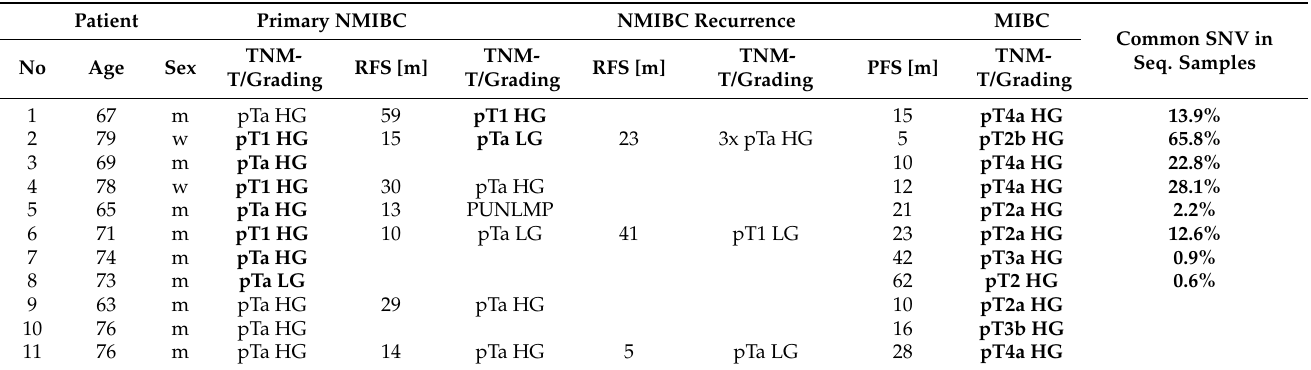
Table 1. Characteristics of patients and tumour